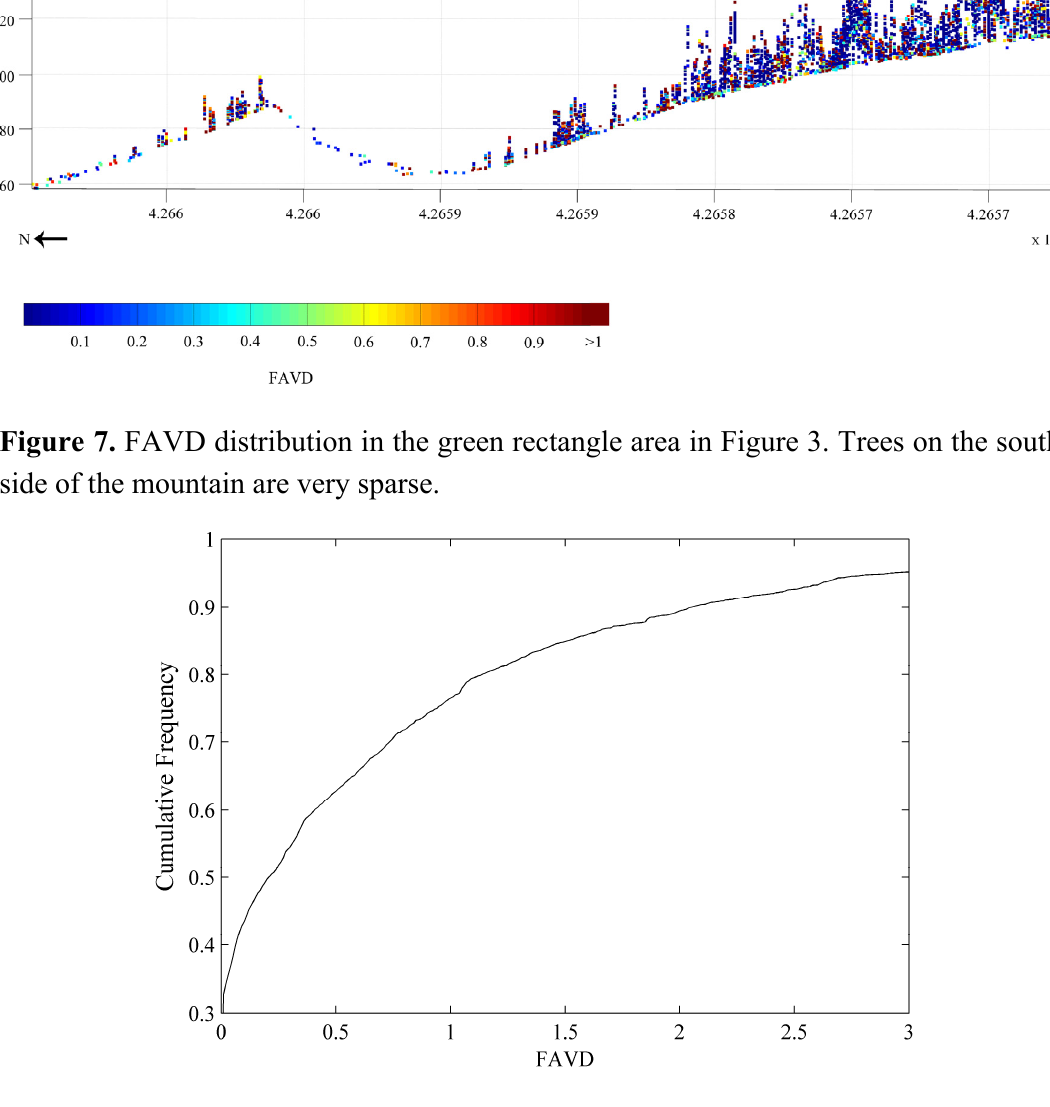
Figure 8. Cumulative frequency distribution of FAVD for the whole study area; 42.5% of FAVD values are below 0.1, 80.1% are below 1, and 94.7% are below